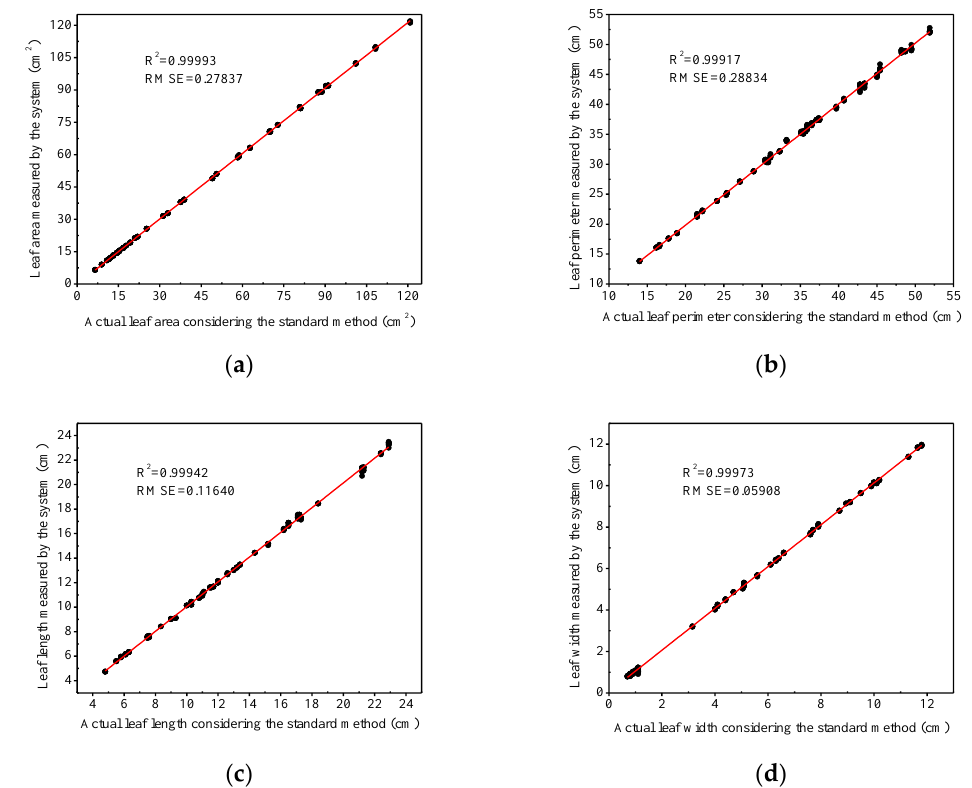
Figure 9. The relationship between leaf geometry parameters measured by the system and the grid method. ( a ) Leaf areas; ( b ) leaf perimeters; ( c ) leaf lengths; and ( d ) leaf widths.